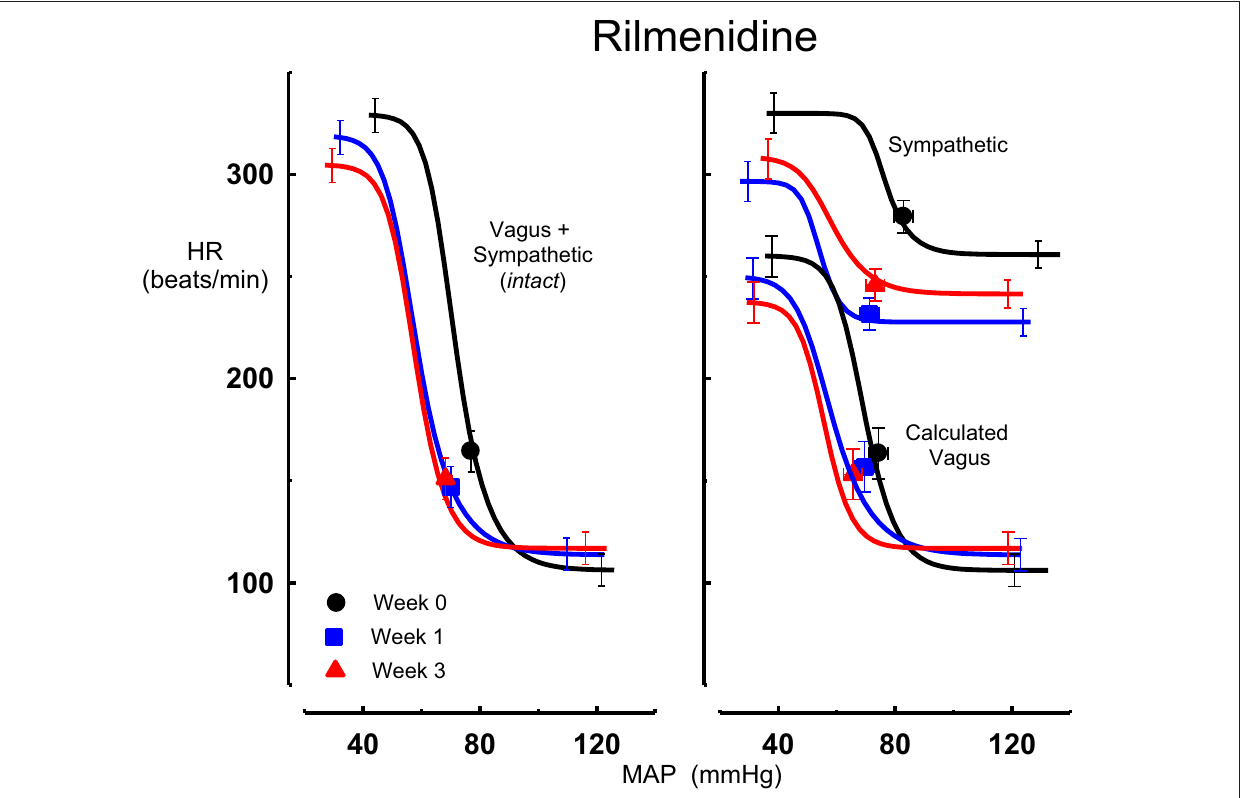
FIGURE 2 | Average sigmoid curves indicating the relationship between mean arterial pressure (MAP, mmHg) and heart rate (HR, beats/min) for the intact baroreflex curves (left panel) and the sympathetic and calculated vagal baroreflex curves (right panel) in eight conscious rabbits before (weeks 0, black line, black circles on all panels) and at weeks 1 (blue line, blue square on all panels) and 3 (red line, red triangle on all panels) of rilmenidine treatment. Symbols on curves represent resting values. Error bars are average SEM indicating variation between animals calculated from the ANOVA.